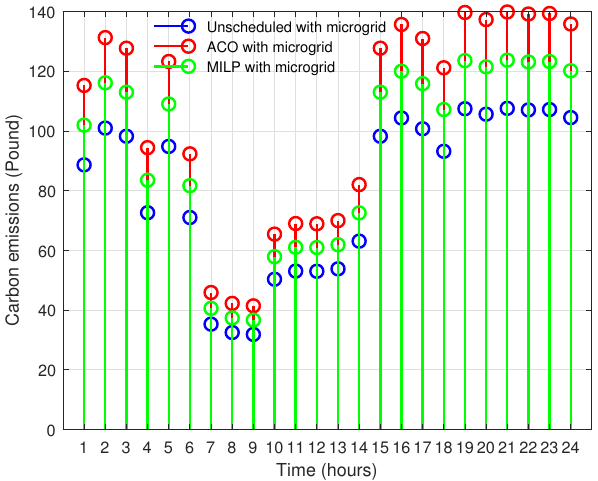
Figure 21. Carbon emission minimization evaluation considering